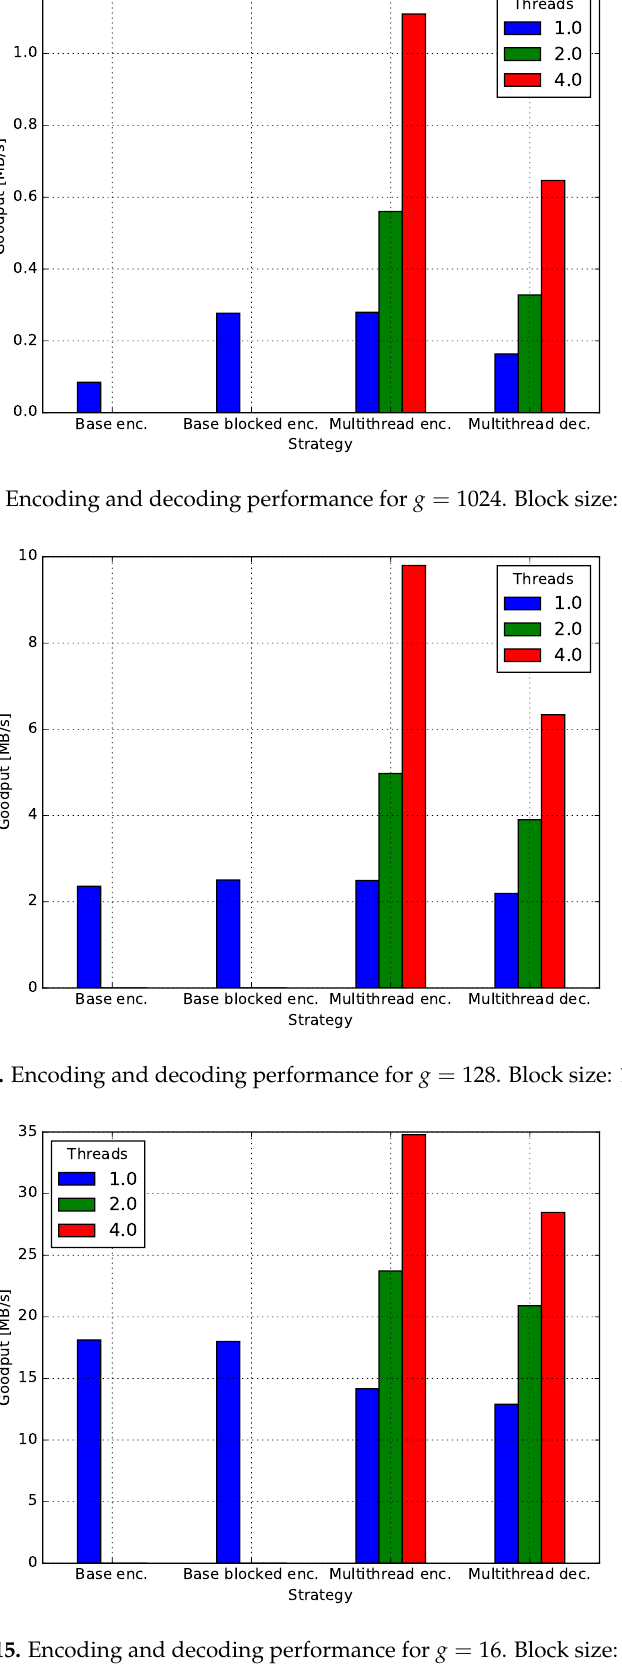
Figure 15. Encoding and decoding performance for g = 16. Block size: 16 ×